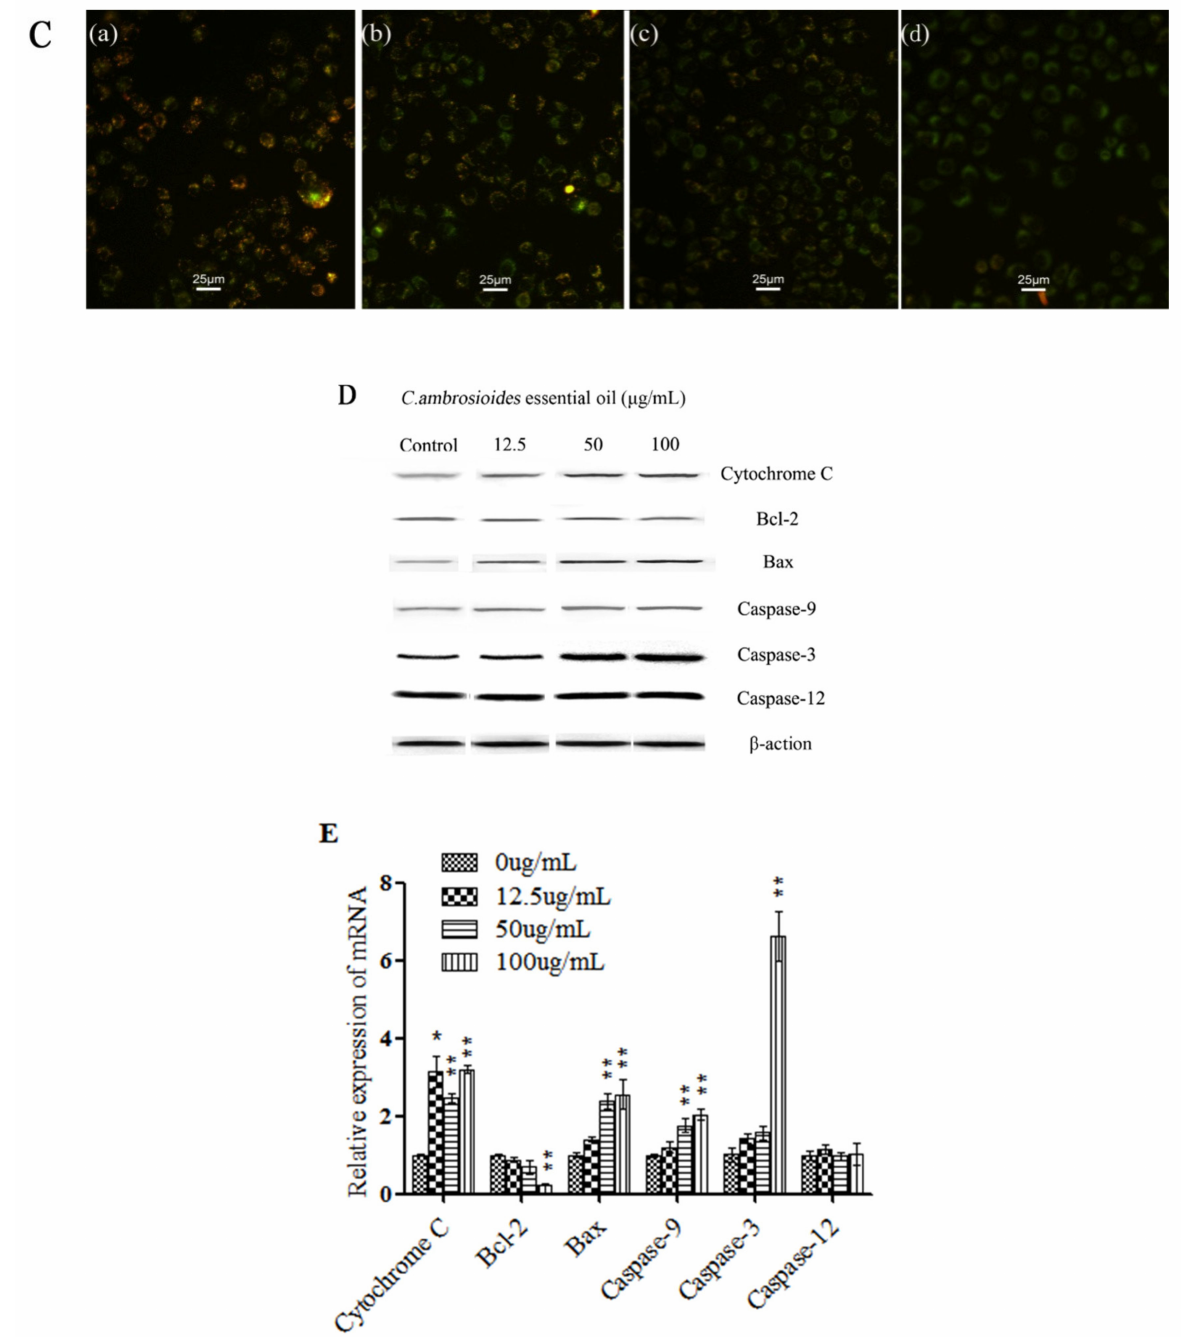
Figure 2. C. ambrosioides essential oil induced apoptosis in the L02 cells. ( A ) AO/EB double staining. (a)–(d) represented the VNA cells, VA cells, NVA cells, and NVNA cells of the L02 cells that had been treated with the essential oil for 24 h at the concentrtion of 0 µ g/mL, 12.5 µ g/mL, 50 µ g/mL and 100 µ g/mL respectively. ( B ) Cells were harvested, stained with Annexin V/PI, and data were acquired by flow cytometer. ( C ) MMP using JC-1 dyeing with fluorescence microscopy. (a)–(d) represented the the MMP of the L02 cells that had been treated for 24 h with DMSO, the essential oil at the concentrition of 12.5 µ g/mL and 50 µ g/mL, carbonyl cyanide-p-chlorophenyl hydrazone (CCCP) respectively. ( D ) Apoptosis related protein expression was detected by Western blot. ( E ) The mRNA expression level of apoptosis related gene was detected by qPCR. Graphical plots derived from three independent experiments, numerical values represent means ± SEM (* p < 0.05, ** p < 0.01, compared with the negative control). Note: VNA = living cells, VA = viable apoptotic cells, NVA = non-viable apoptotic cells, and NVNA = non-viable non-apoptotic